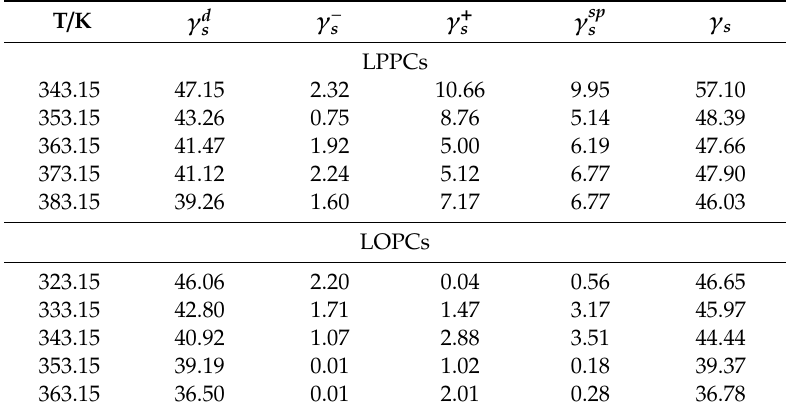
Table A8. Dispersion component, specific component and total surface energy of LPPCs and LOPCs at di ff erent temperatures.